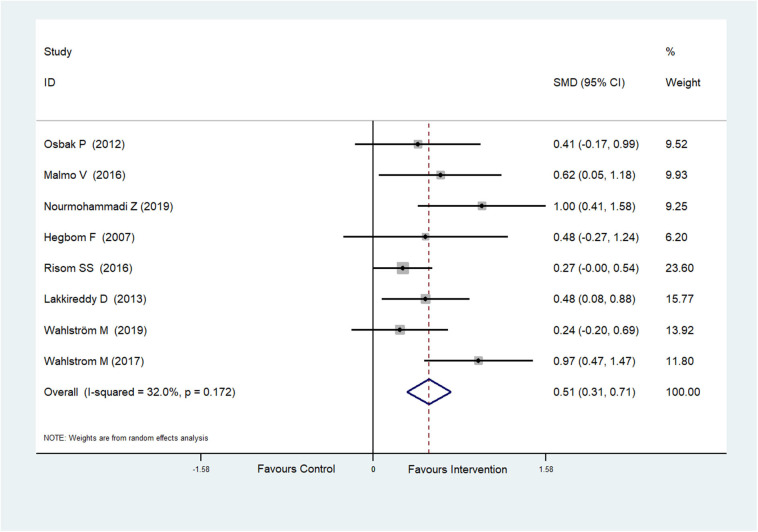
Forest plot shows the ES of physical exercise on Vitality in AF patients.